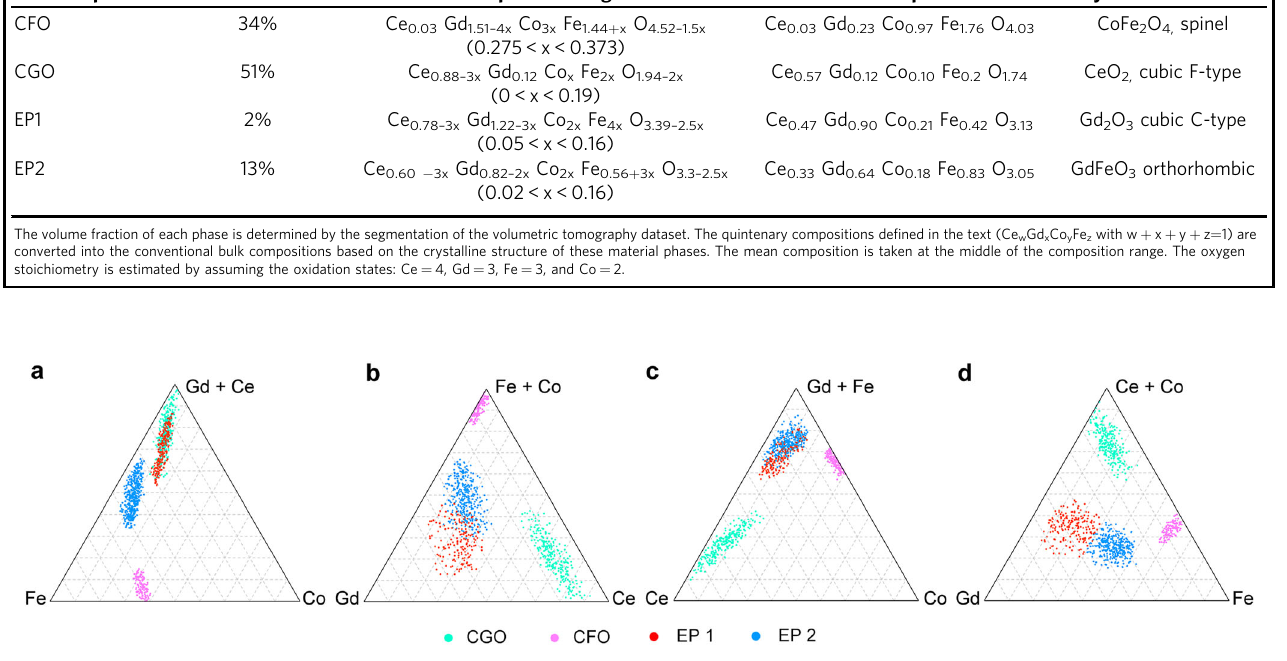
Table 1 Composition of the four materials phases in the CGO-CFO MIEC system and their crystalline structure. Material phase